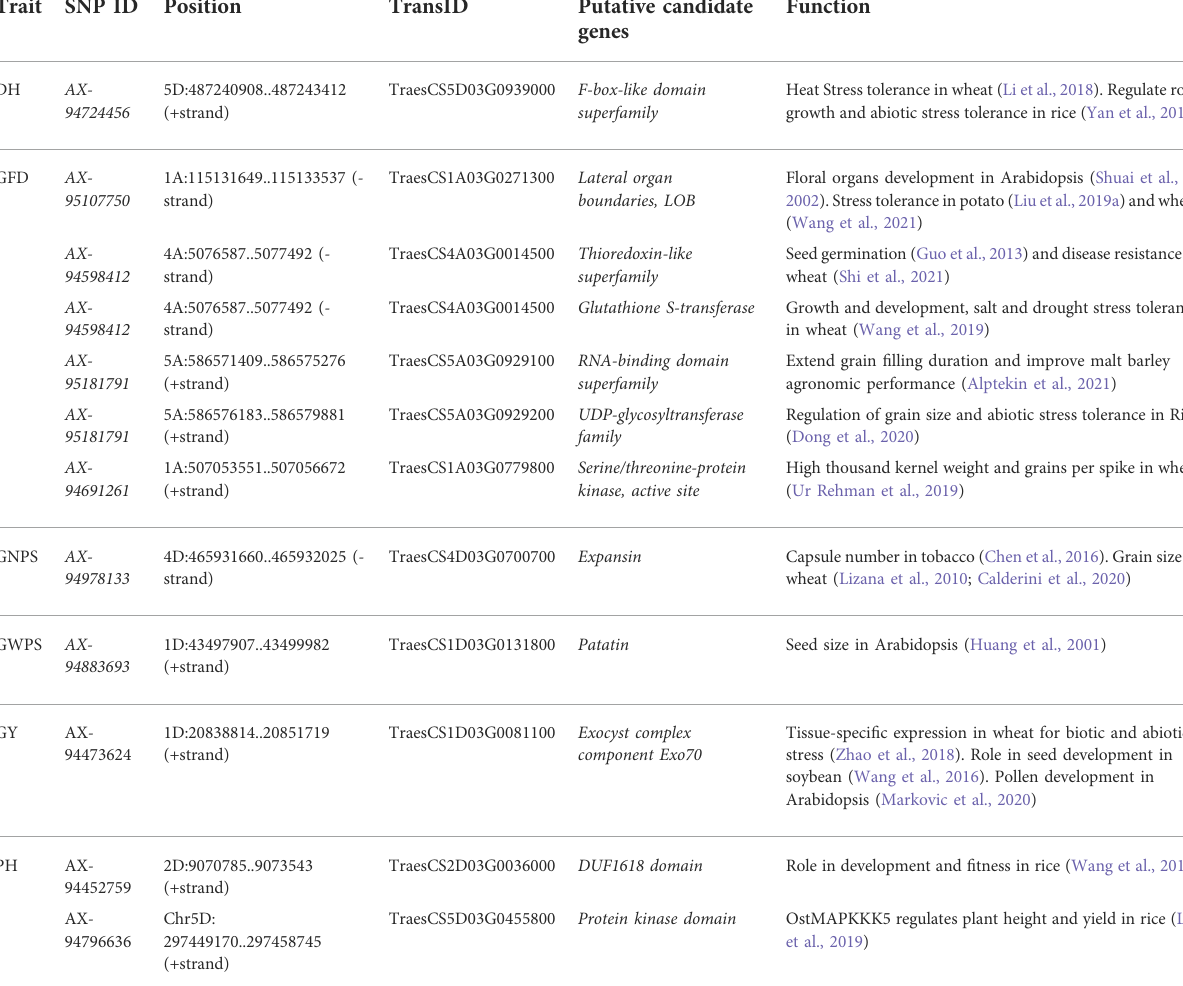
TABLE 4 Putative candidate genes for grain yield and component traits. Trait SNP